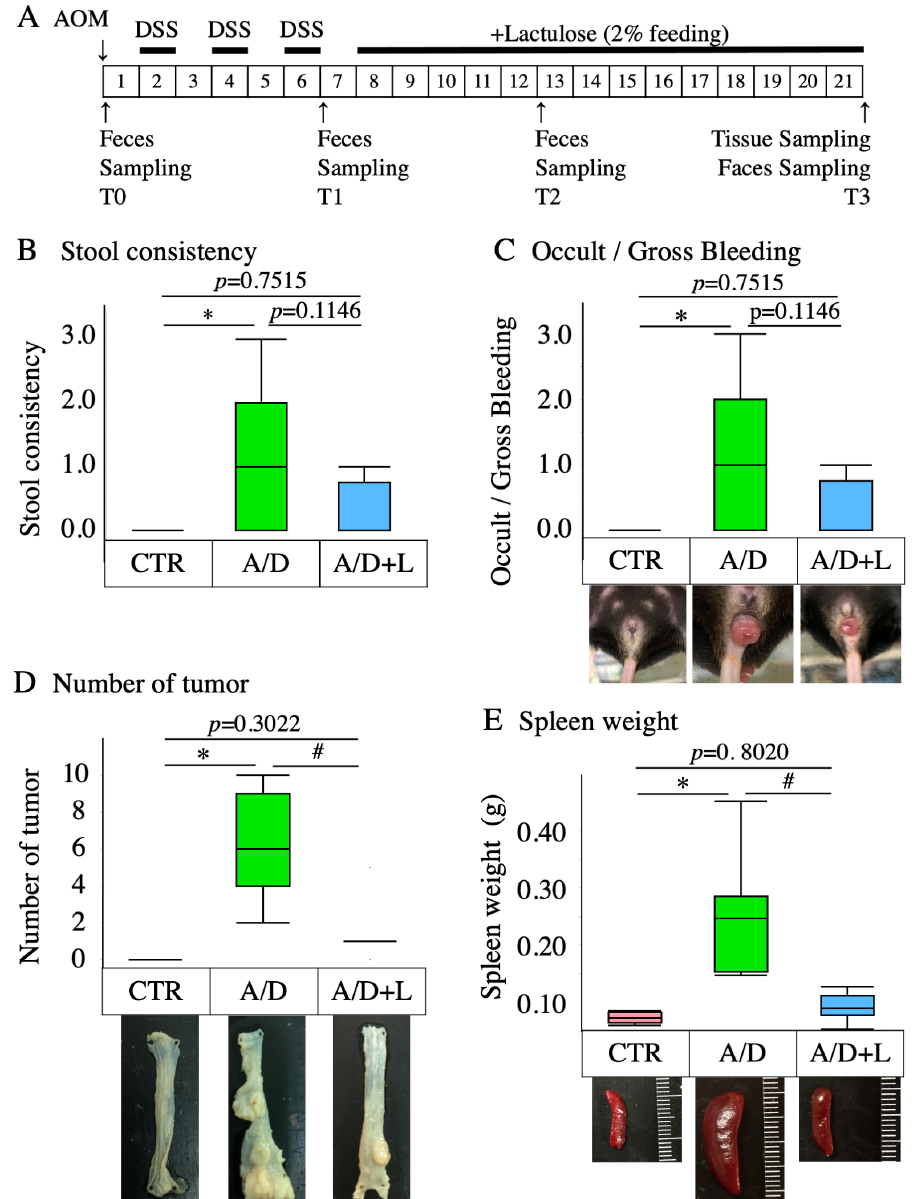
Figure 1. Inhibitory effect of lactulose on the development of AOS/DSS model-related pathology. ( A ) The experimental protocol for the generation of the AOM/DSS model (A/D) and subsequent treatment with lactulose (A/D+L) is shown. Mice were intraperitoneally injected with azoxymethane (AOM) (12 mg/kg body weight) on day 0. One week later, treatment with dextran sulfate sodium (DSS) was initiated by providing the mice 2% DSS in drinking water for 1 week. The 1-week DSS treatment was repeated 3 times with a 1-week interval. One week after the last treatment with DSS, lactulose treatment was initiated. The mice were fed lactulose-containing chow for 14 weeks. The dose of lactulose was approximately 2 g/kg weight/day. In the AOM/DSS group without lactulose treatment (A/D), the normal chow replaced the lactulose-containing chow. In the control group (CTR), administration of AOM, DSS and lactulose was omitted. Stool samples were collected on day 0 (T0) and 6 weeks (T1), 12 weeks (T2), and 21 weeks (T3) after AOM injection. All evaluations were performed 21 weeks after AOM injection. B–E: Summaries of the score of stool consistency ( B ), the scores of abnormal/gross bleedings ( C ), the weight of the spleen ( D ), and the number of tumors ( E ). Data are shown in boxplots ( n = 8). * p < 0.05 vs. CTR, # p < 0.05 vs. AOM/DSS.